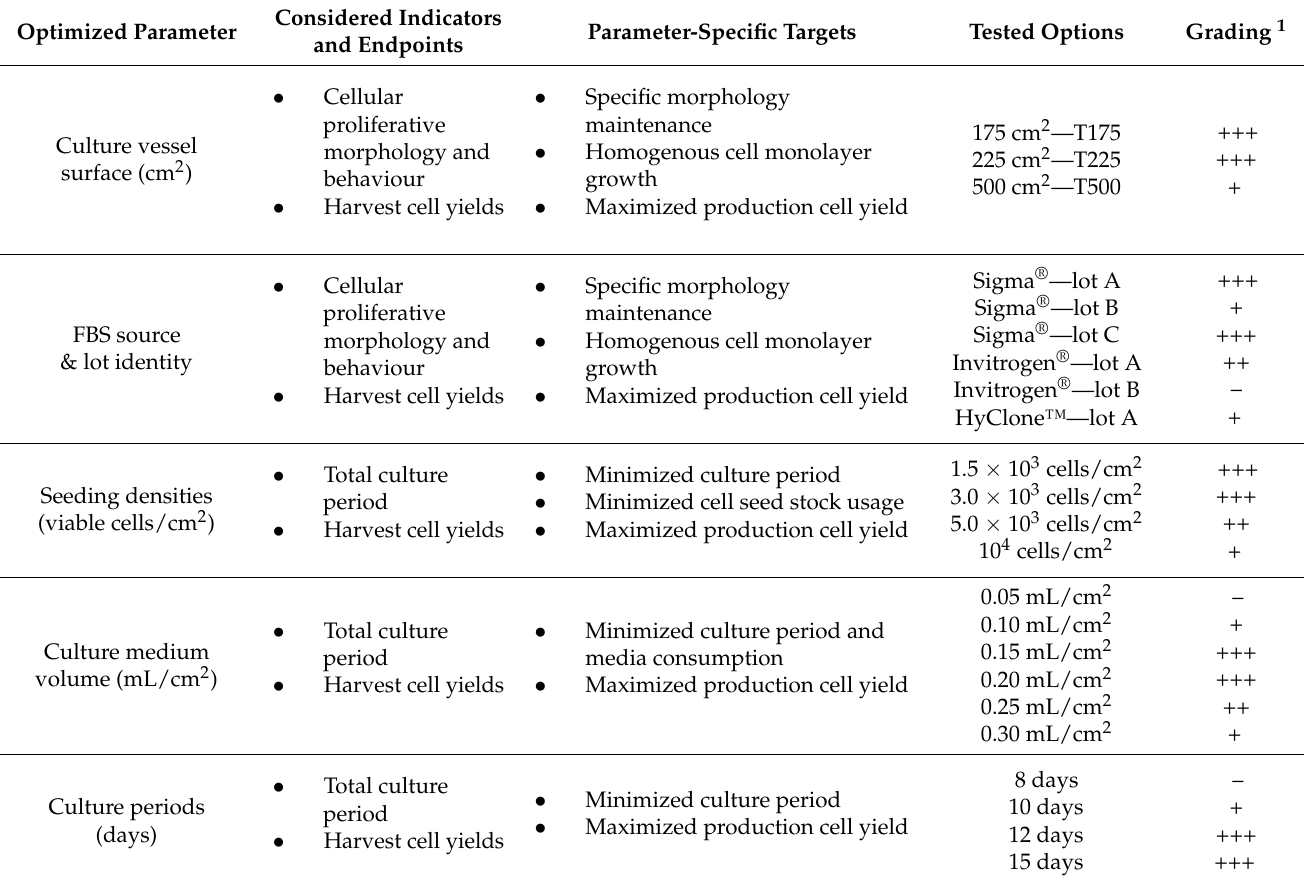
Table 1. Results of multi-parameter optimization and corresponding grading of raw and ancillary materials, contact-process consumables, and culture conditions for large-scale manufacturing of dermal FPCs. FBS is considered here both as a raw and ancillary material, as it is used as a culture medium supplement and as a component of the cell cryopreservation medium. Optimal culture surfaces were selected based on observed proliferative cellular behaviour and harvest cell yields. Optimal FBS sources were chosen based on harvest cell yields and availability of large commercial lots of the appropriate quality. Optimal cell seeding densities, culture medium volumes, and culture periods were selected based on cellular behaviour in culture, harvest cell yields, and sparing use of cell seed stocks, materials, and manufacturing suite use, respectively. Grading was performed using the abbreviated nomenclature presented hereafter. (–) = unsatisfactory, (+) = sub-optimal, (++) = satisfactory, (+++) = optimal. FBS, fetal bovine serum; FPC, fibroblast progenitor